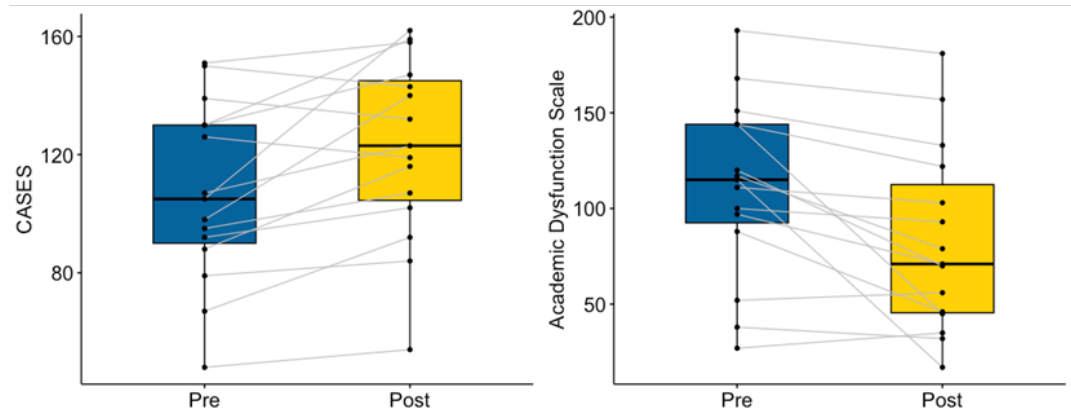
Figure 5. Mentee Pre- and Post-Mentoring Academic Function.